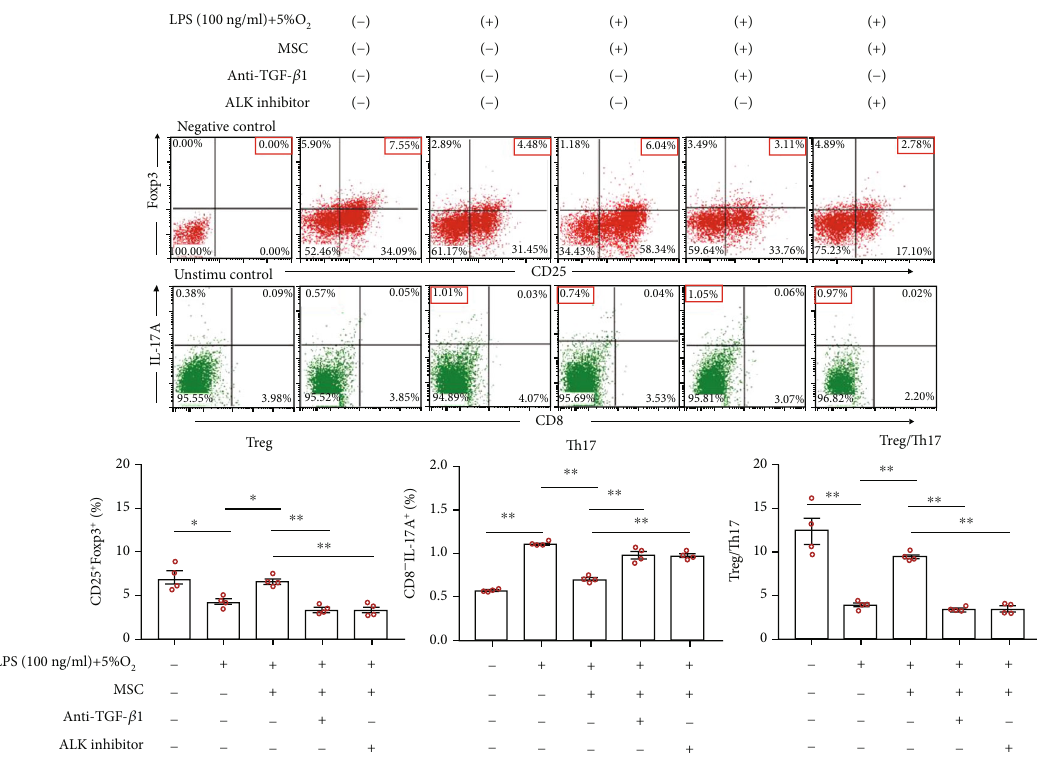
Figure 3: E ff ects of anti-TGF- β 1 neutralization and blocking TGF- β 1-mediated signal on LPS- and hypoxia-induced Treg/Th17 skewing in response to MSC indirect treatment. Representative fl ow plots were shown. Bar graphs represent meanfrequency ± SEM of Treg and Th17 and meanvalues ± SEM of Treg/Th17 ratios in the various groups. LPS: lipopolysaccharide; SEM: standard error of the mean; TGF: transforming growth factor; Th: T helper; Treg: regulatory T cells. ∗ P < 0 : 05 and ∗∗ P < 0 : 01 .